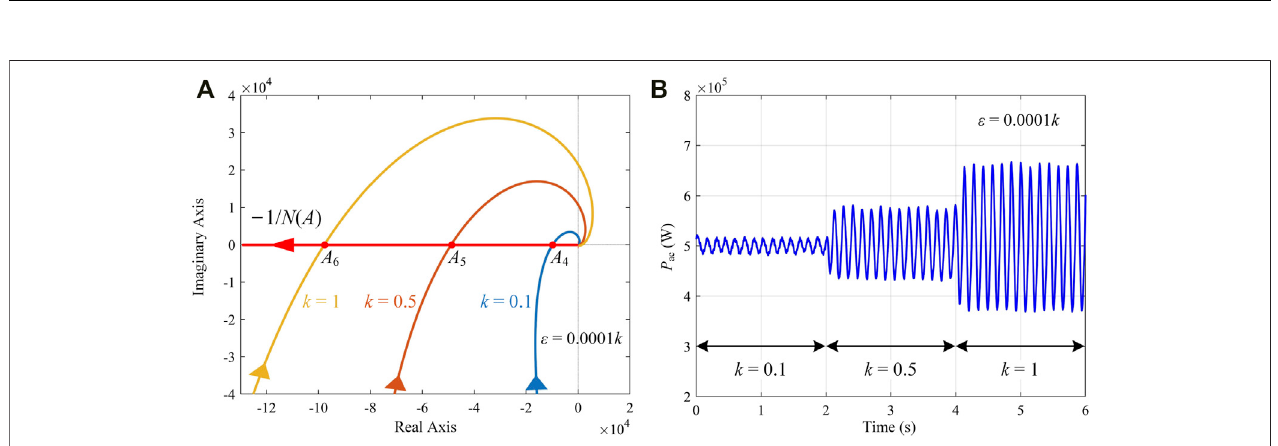
FIGURE 6 | Stability analyses and simulations when changing the perturbation step ε . (A) Stability analyses based on the DF method. (B) Power output.